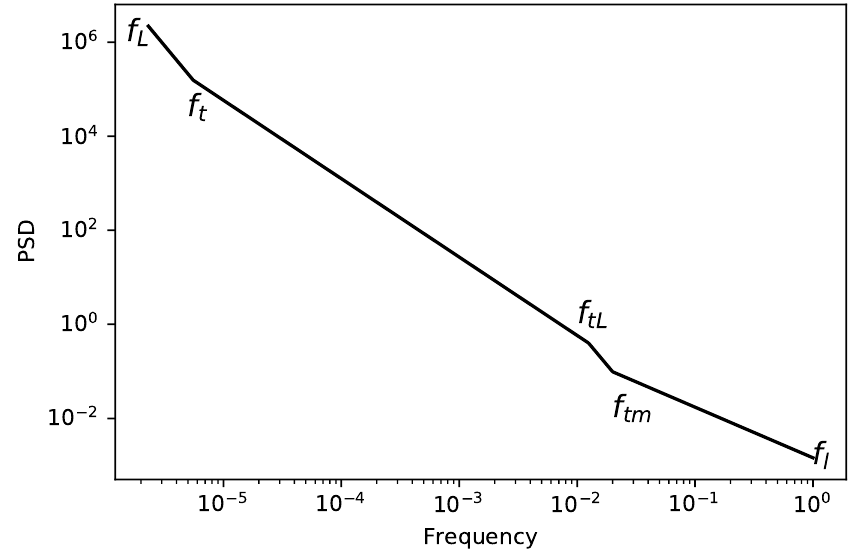
Figure 1. The scheme of the energy spectrum of the atmospheric turbulent flow. The frequencies are shown by f L , f t , f tL , f tm , f l . The dimensionless frequencies and power spectral density of the air temperature fluctuations are shown along the horizontal and vertical axes (in logarithmic